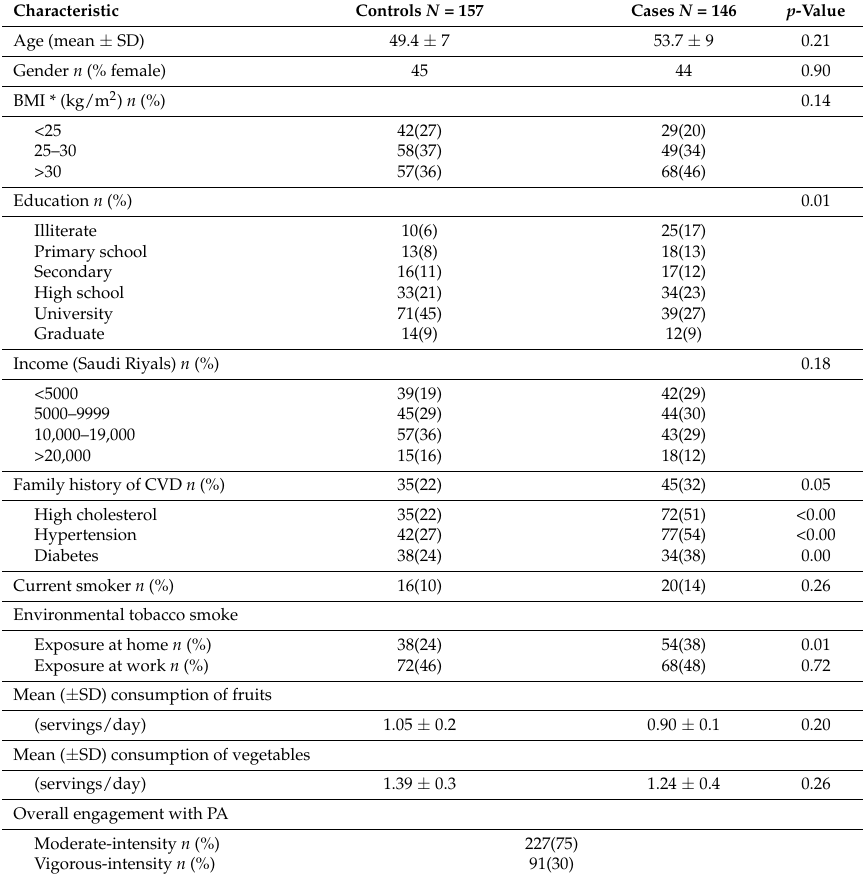
Table 1. Sociodemographic characteristics of